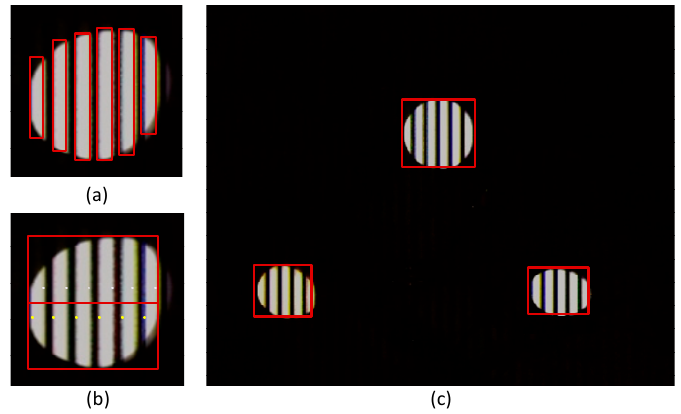
Figure 6. Multiple object detection. ( a ) Individual stripe detection of a single LED (requires much processing time). ( b ) A single LED detection using a rectangle (requires less processing time). ( c ) Multiple object detection using a rectangle (optimum).